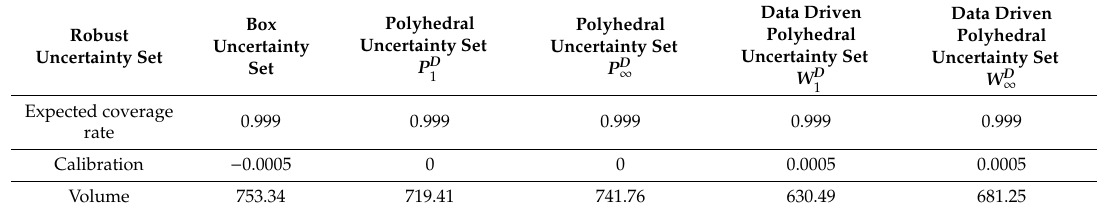
Table 1. Comparison of calibration and volume for di ff erent data driven robust uncertainty sets. Box Robust Uncertainty Uncertainty Set